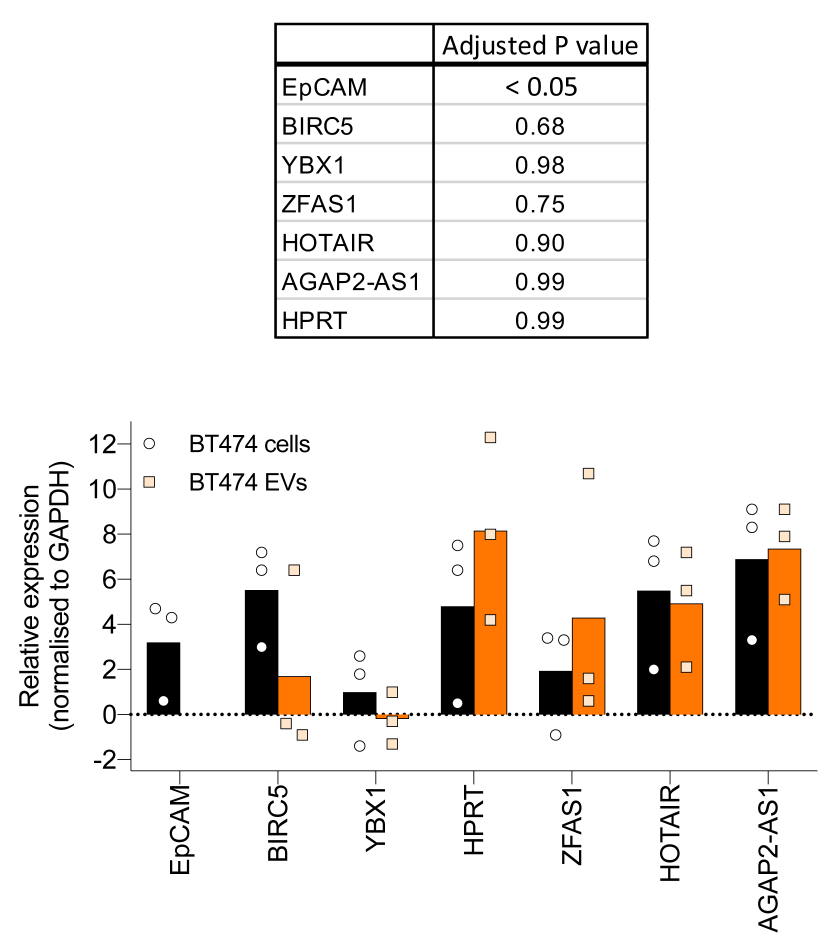
Figure S1. Fold change in the RNA expression of five protein-coding genes ( EpCAM, BIRC5, YBX1, HPRT1 ) and three long non- coding RNAs ( ZFAS1, HOTAIR, AGAP2-AS1 ) in BT-474 EVs versus cells (control). Error bars denote standard errors of the